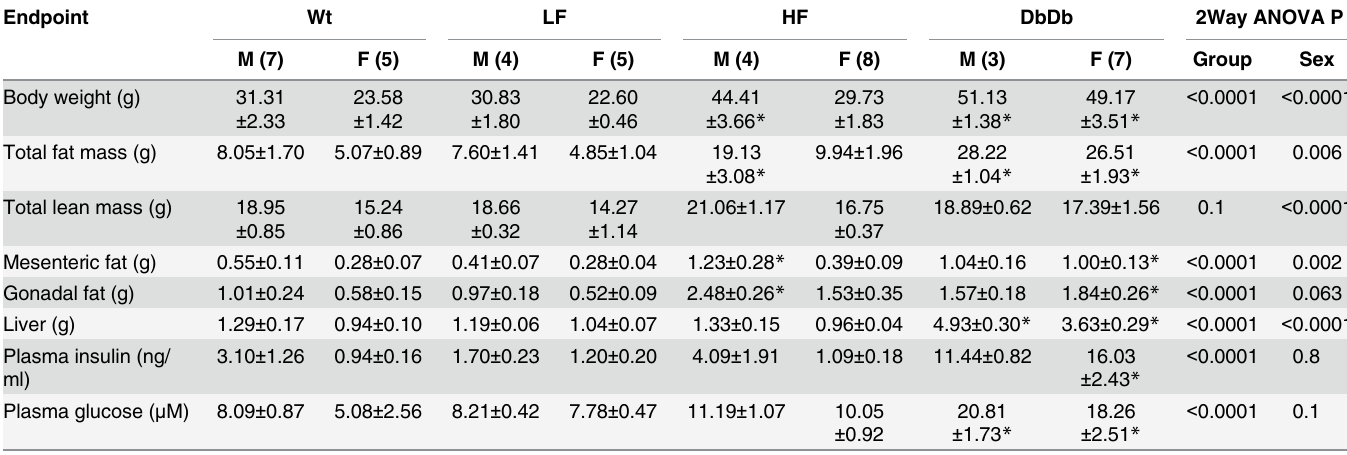
Table 2. Physiological characteristics of mice by group.